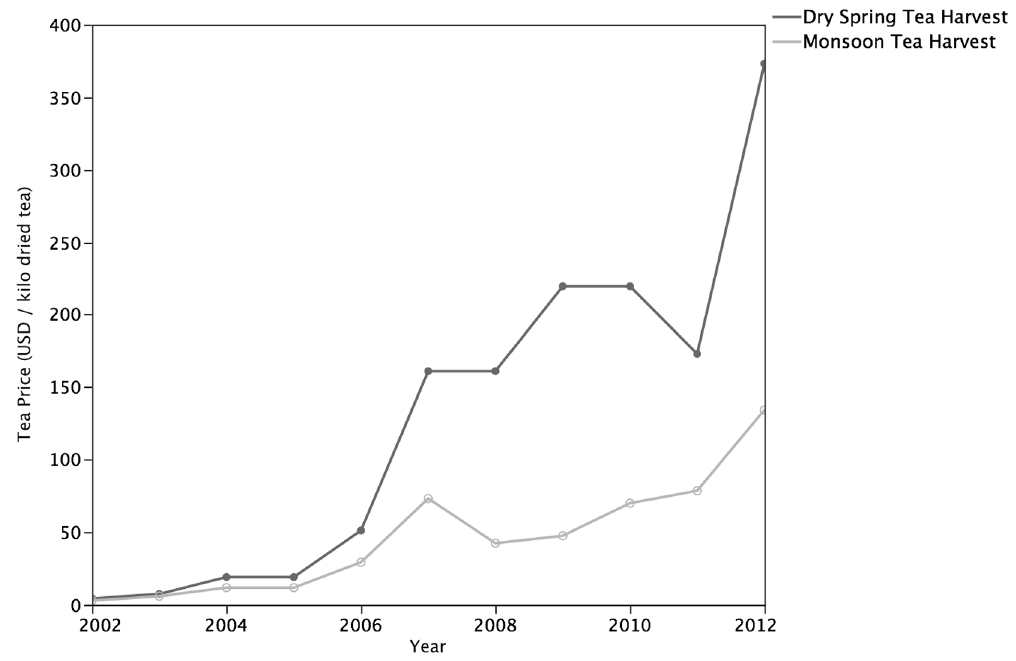
Figure 6. Effects of Precipitation Variability on Tea Prices. Farmers at the study site have experienced an average decrease of 51% in on-farm tea prices received during the Monsoon tea harvests compared to the dry spring tea harvests.